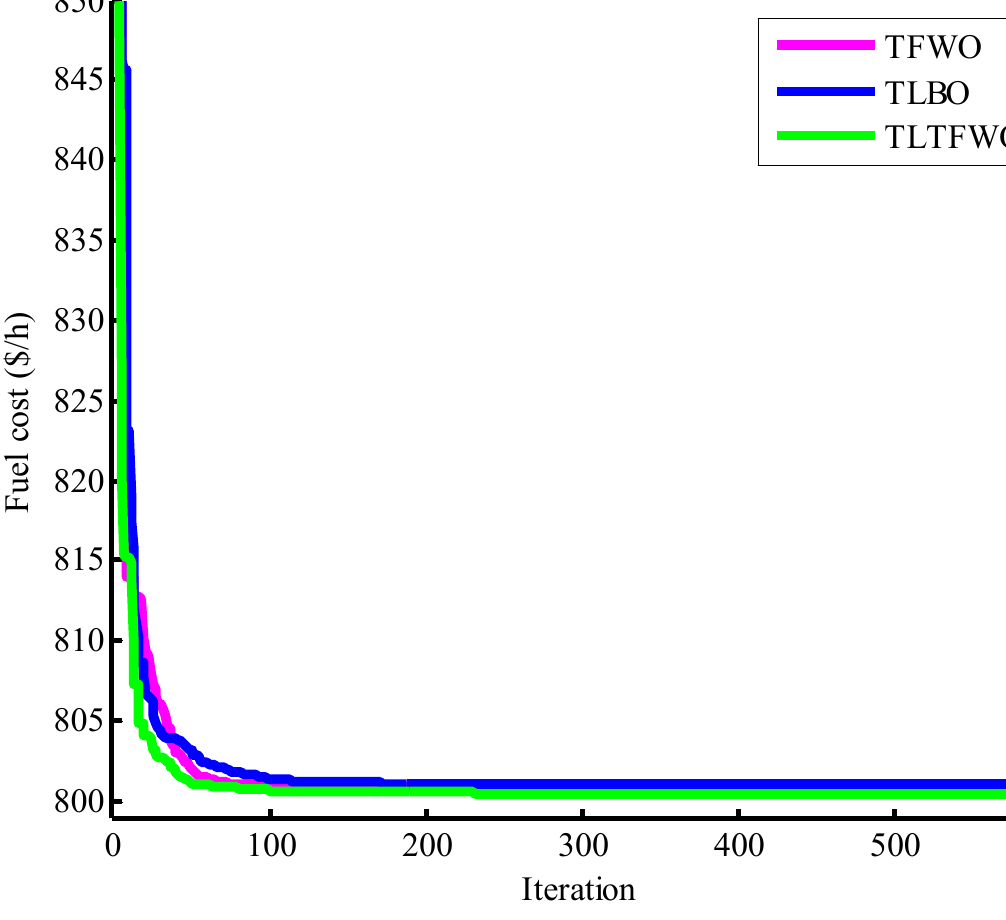
Figure 5. Convergence trends for Case 1.